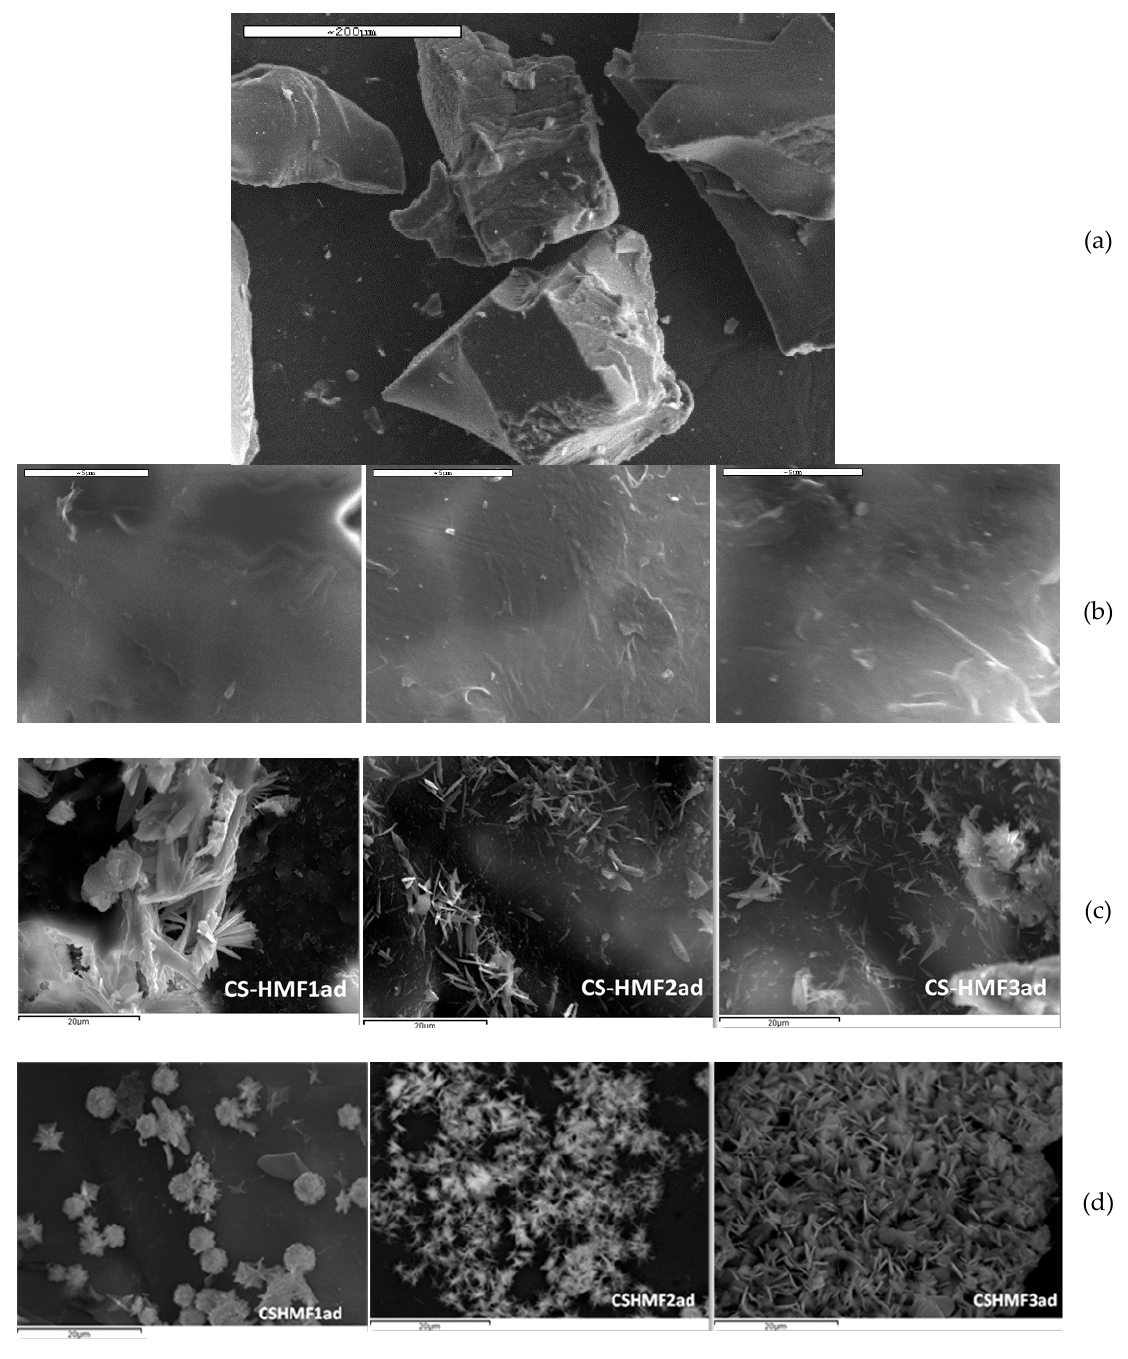
Figure 2. SEM images: ( a ) CS0; ( b ) CS-HMF derivatives before adsorption; ( c ) CS-HMF derivatives after Cu 2+ adsorption; ( d ) CS-HMF derivatives after Cd 2+ adsorption.